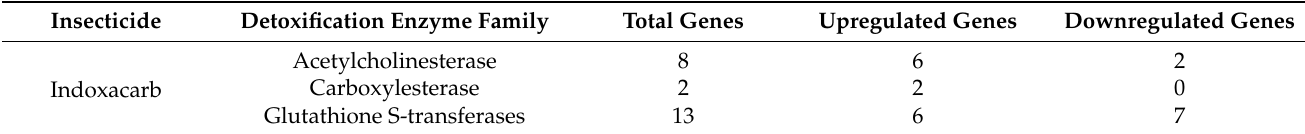
Figure 6. Heatmap of expression of genes related to acetylcholine esterase (AChE), carboxylesterase (CarE), and glutathione S-transferases (GSTs), based on mean FPKM values exposed to indoxacarb (after 24 h). Table 2. A list of insecticide detoxification genes regulated in the transcriptional data of Solenopsis invicta